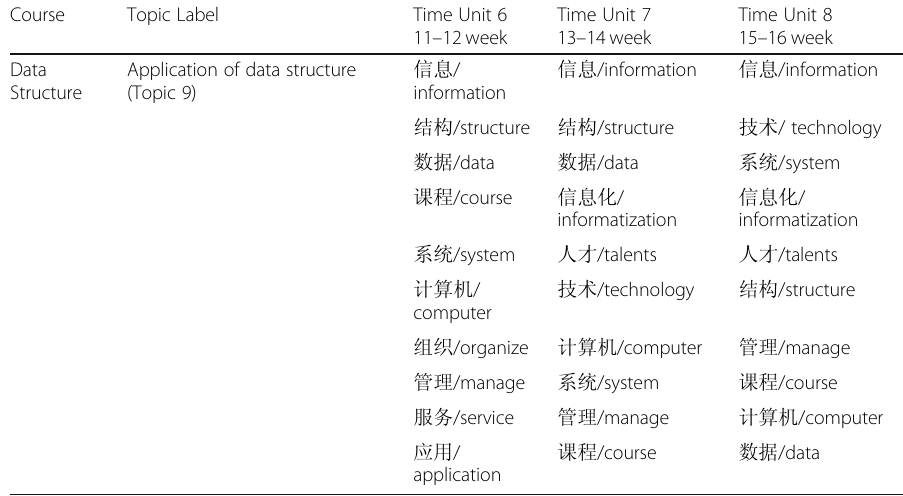
Table 5 The evolution of topic content about the application of data structure over time